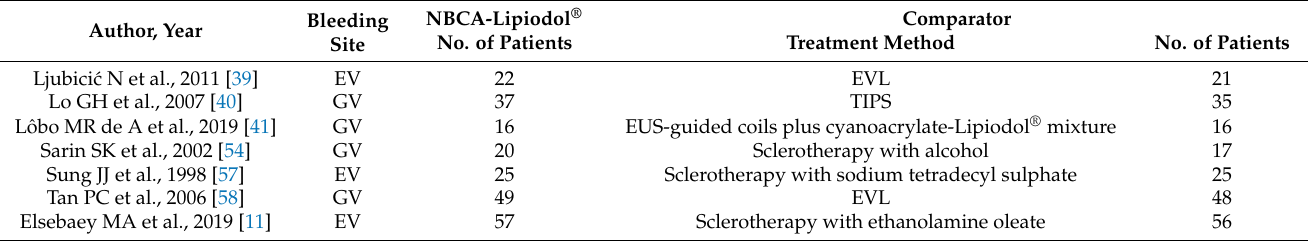
Table 3. Characteristics of the randomized controlled trials included in the meta-analysis that compared NBCA-Lipiodol ® injection to another treatment method (comparator).